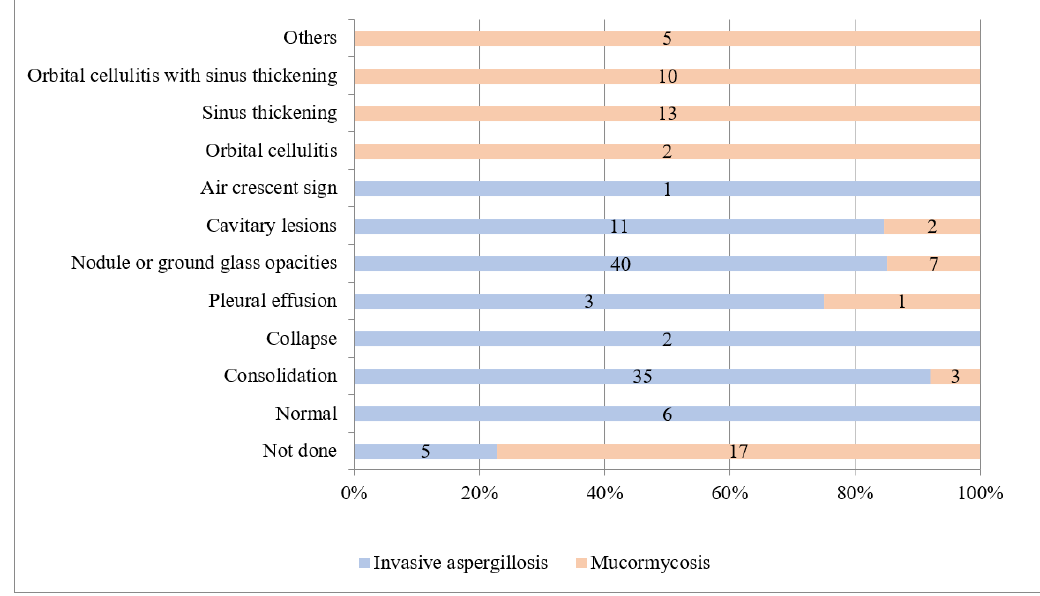
Figure 4. Radiological findings in invasive aspergillosis and mucormycosis cases.